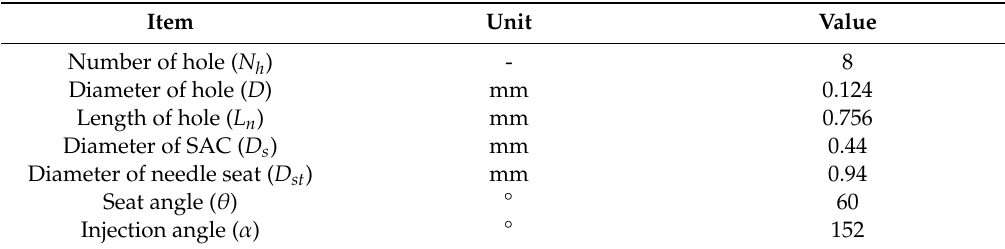
Table 1. Specifications of the base injector